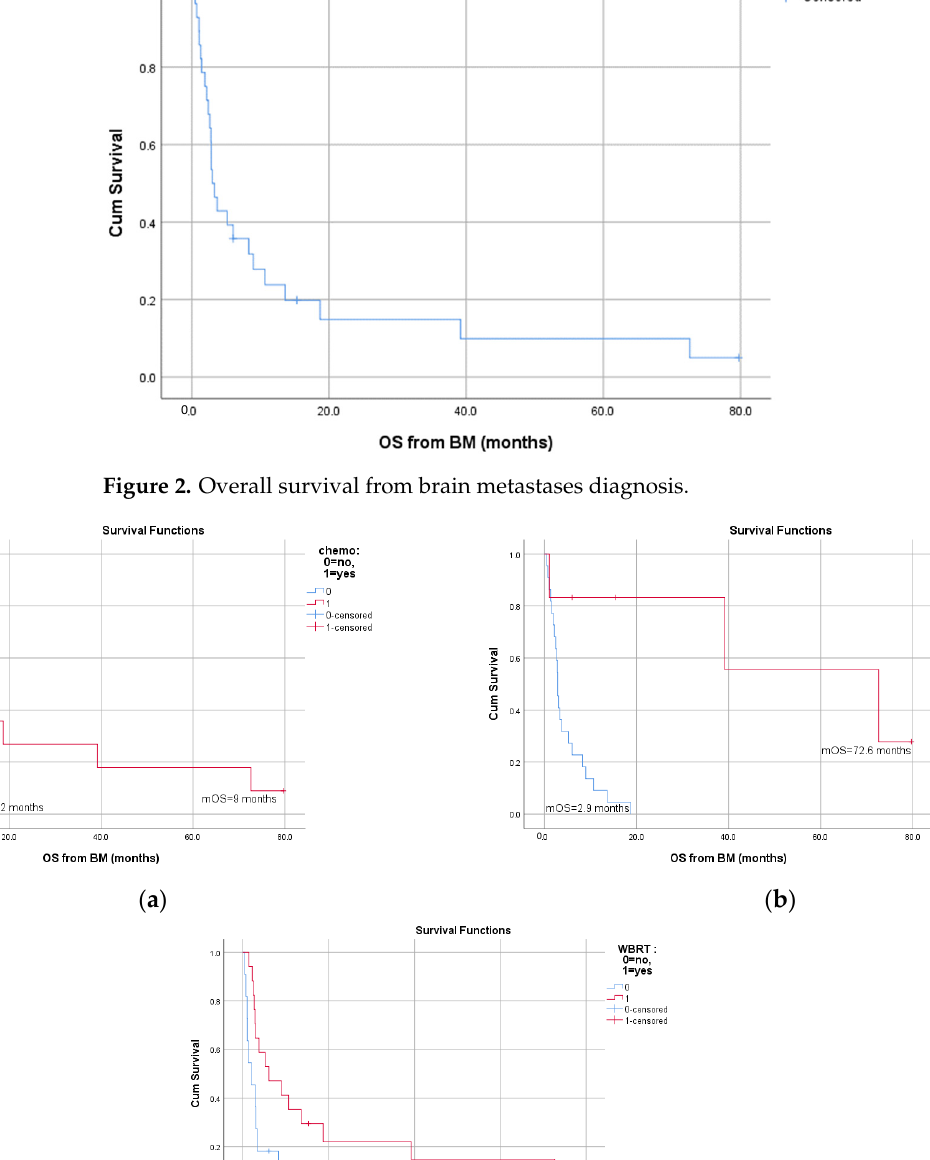
Figure 2. Overall survival from brain metastases diagnosis.